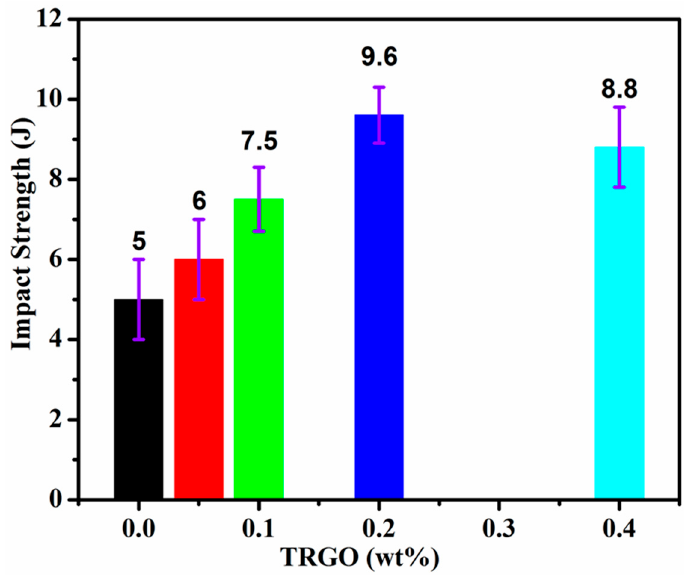
Figure 8. Effect of TRGO on impact strength of the prepared CF/epoxy composites.